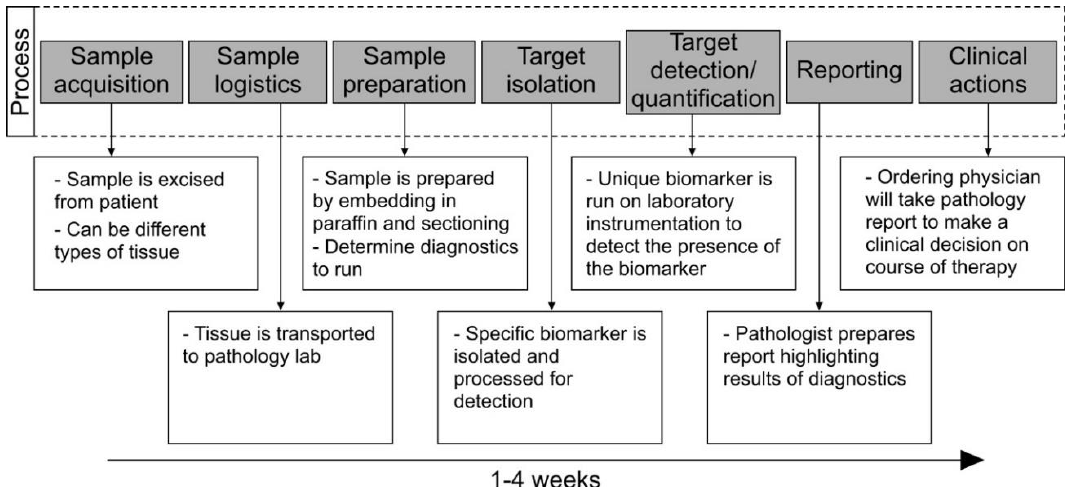
Figure 2. Melanoma diagnostic workflow (reproduced from [12]).